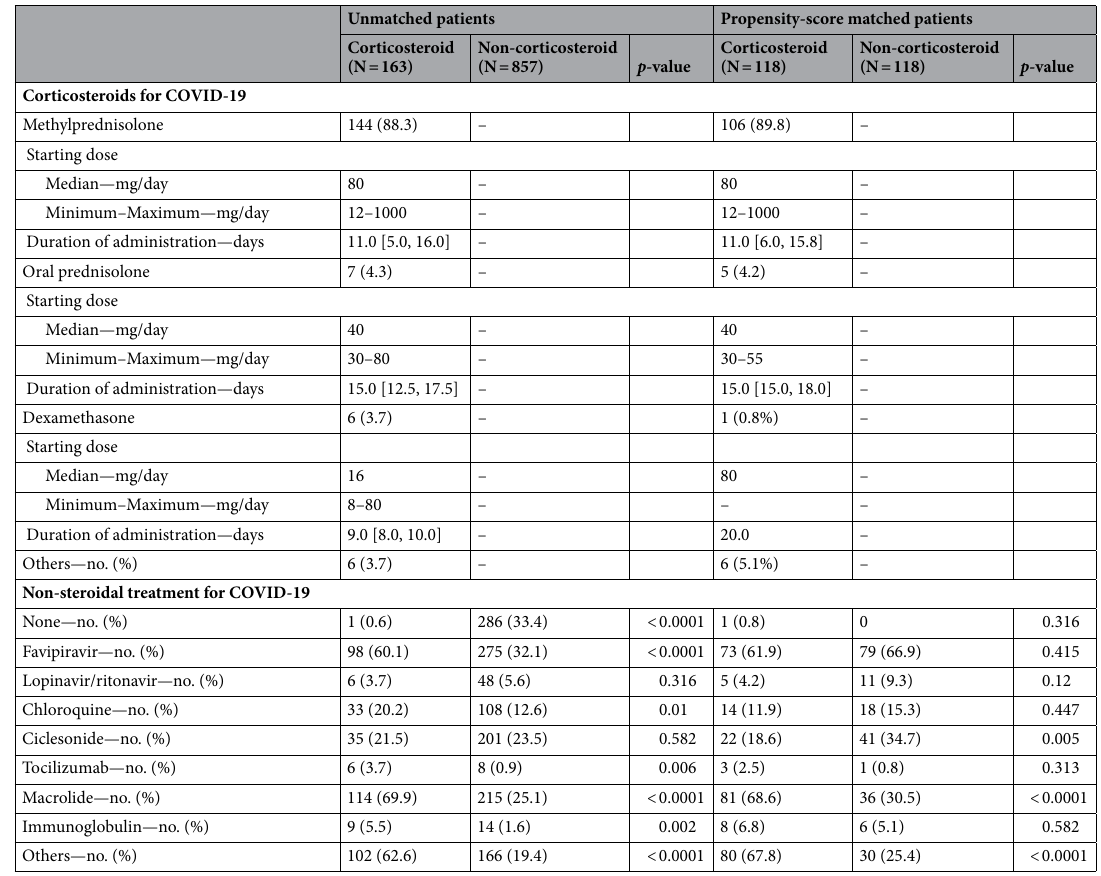
Table 2. Treatment for coronavirus disease 2019. Unmatched patients refer to the total of 1020 enrolled patients (163 patients who received early corticosteroids for COVID-19 and 857 patients who did not receive systemic corticosteroids for COVID-19) subject to propensity score matching in this study. Categorical variables were presented as numbers (%), and compared using the chi square test. Continuous variables related to time were presented as median [interquartile ranges] and compared using the t test. A p value of < 0.05 was considered statistically significant. COVID-19, coronavirus disease 2019.